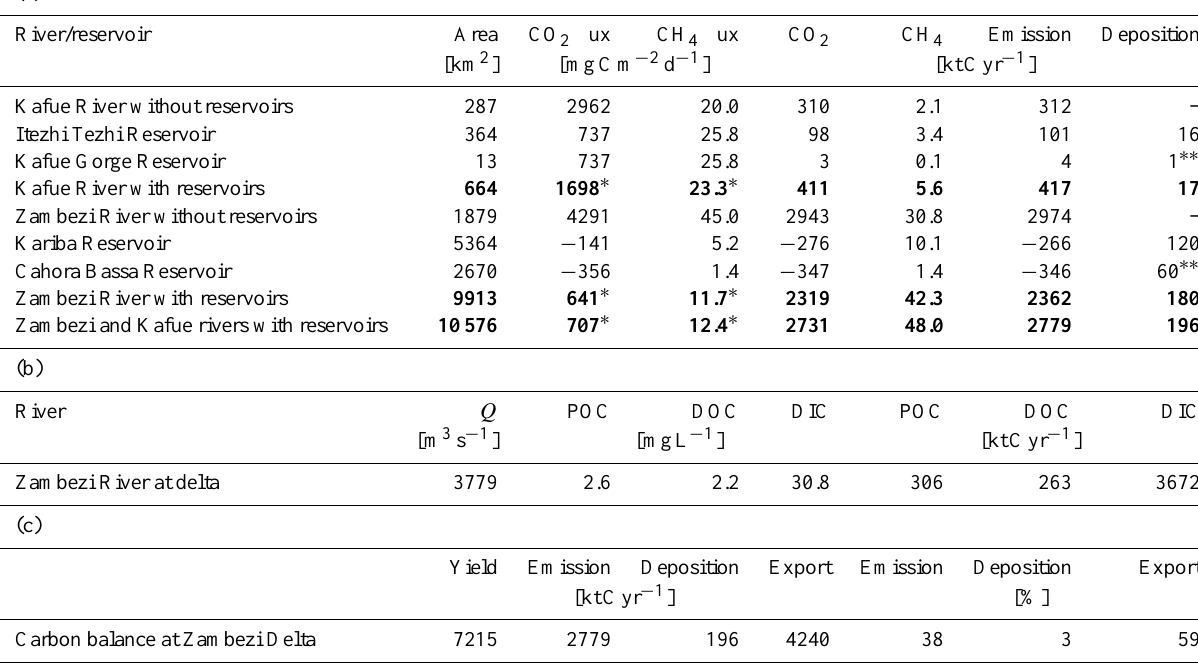
Table 1. (a) Carbon emission estimates based on measured CO 2 and CH 4 fluxes (this work) and carbon removal by deposition in reservoirs based on available published data (Kunz et al., 2011a, b); (b) carbon export loads to the ocean calculated using average literature river discharge at the Zambezi Delta and POC, DOC and DIC concentrations (this work) measured at the river mouth (ZBZ.19 and ZBZ.20) during the 2012 and 2013 wet season campaigns; and (c) carbon mass balance components including yield, emission, deposition and export. Data marked with ∗ represent areal fluxes recalculated for the entire surface including reservoirs. Carbon deposition in the Kafue Gorge and Cahora Bassa reservoirs ( ∗∗ ) were estimated assuming same deposition rates of the Itezhi Tezhi and the Kariba reservoirs. All loads are expressed in ktCyr − 1